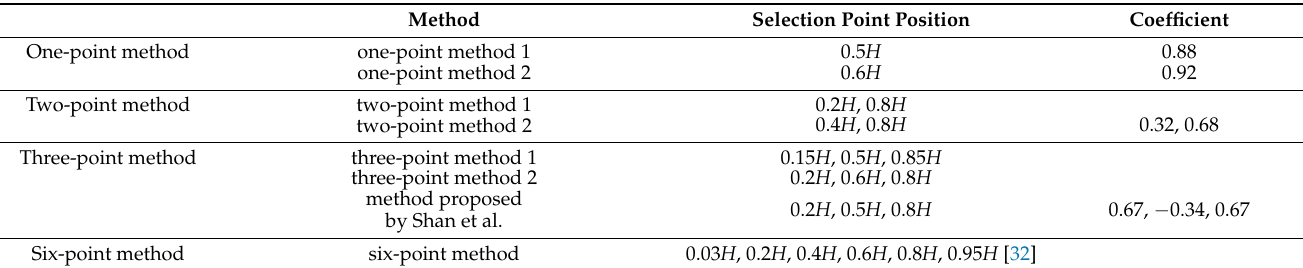
Table 1. Depth-averaged velocity estimation